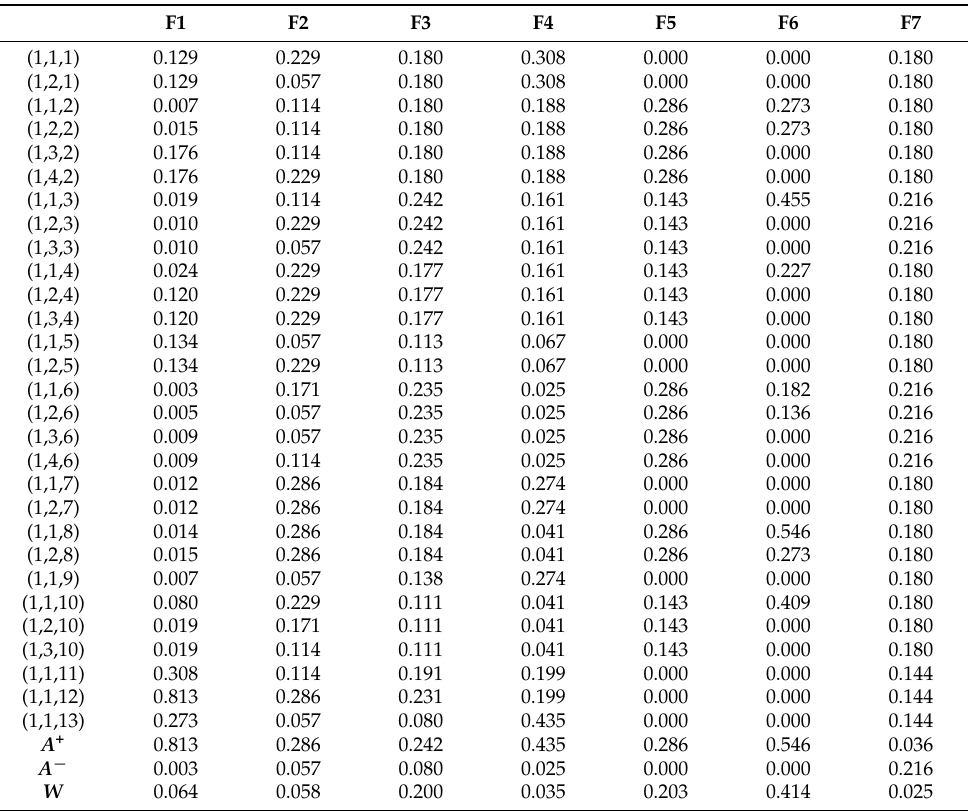
Table A8. The normalized decision matrix R in TOPSIS application—1st iteration.